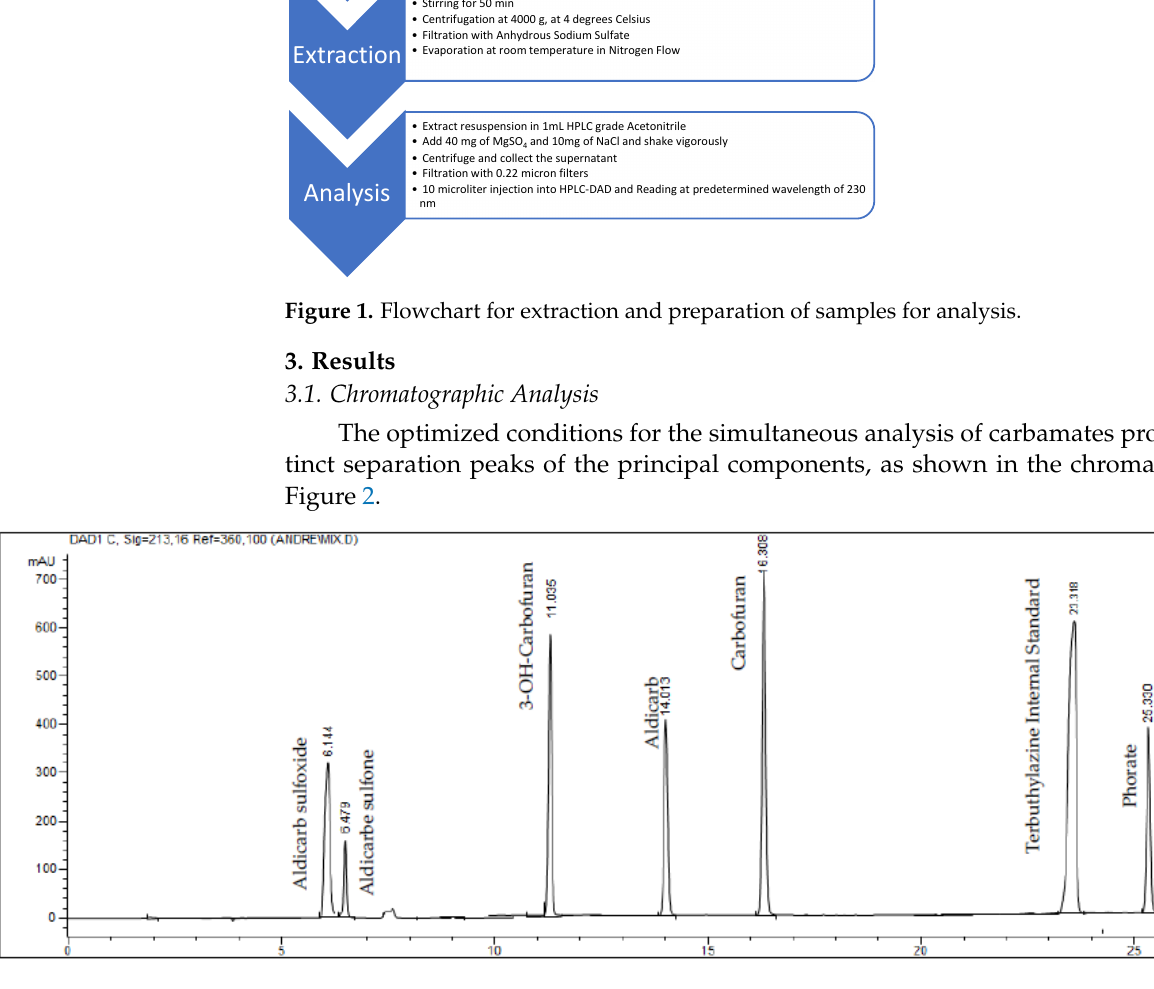
Figure 2. Chromatogram of carbamates by HPLC–DAD . Simultaneous analysis of carbamates shows distinct separation of peaks that correspond to each tested carbamate. Notice the high resolution for each principal component and the absence of background noise.